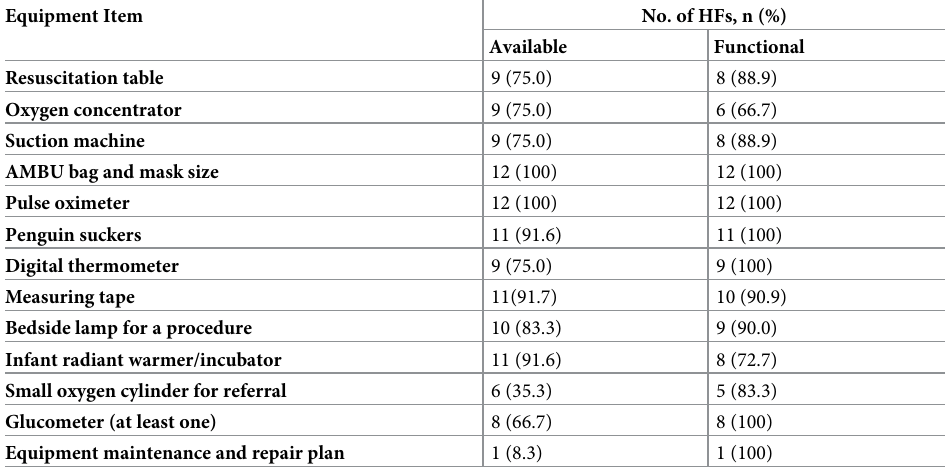
Table 6. Availability of essential newborn care equipment and repair plan, (N = 12).